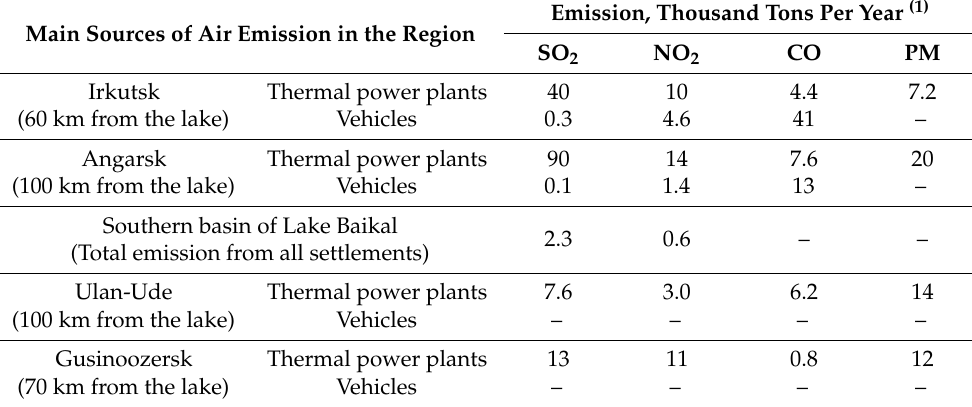
Table 1. Annual volumes of air pollutant emissions by the main cities of the region [9]. Main Sources of Air Emission in the